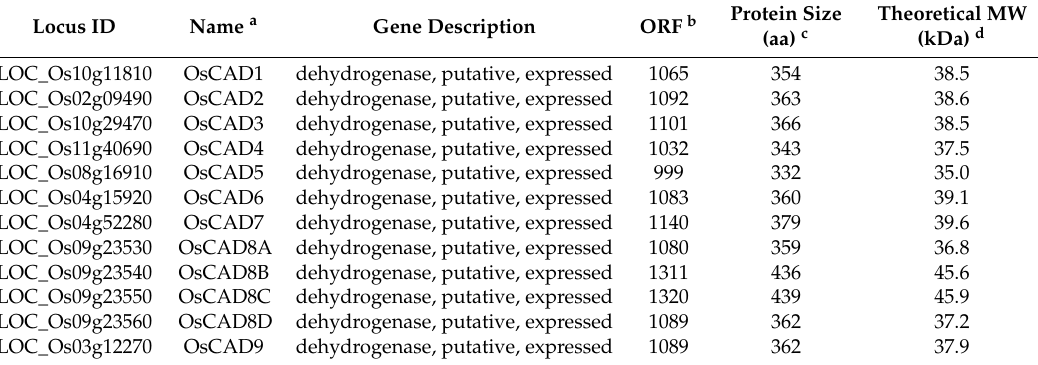
Table 1. Rice CAD and CAD-like gene family retrieved from the MSU RGAP